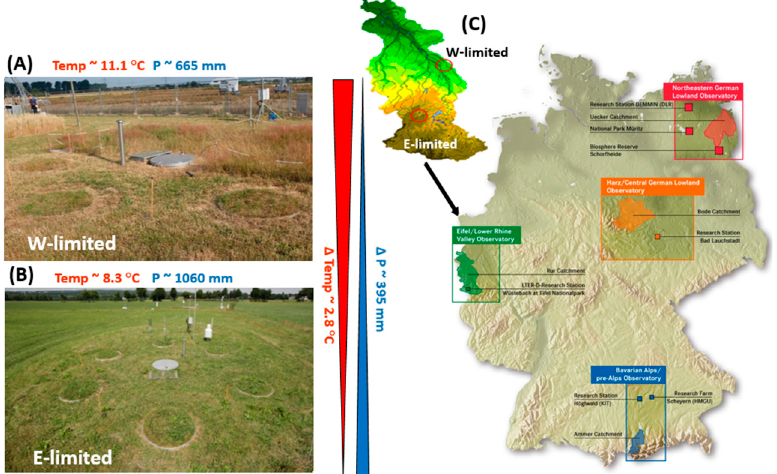
Figure A1. Study sites and mean temperature and precipitation of (A) Selhausen, the water-limited site (W-limited) and (B) Rollesbroich, the energy-limited site (E-limited) located in Eifel/Lower Rhine Valley (c) of the German Terrestrial Environmental Observatories (TERENO) in Germany. The ∆ Temp and ∆ P are the changes in temperature and precipitation. Modified from Rahmati et al. [37].